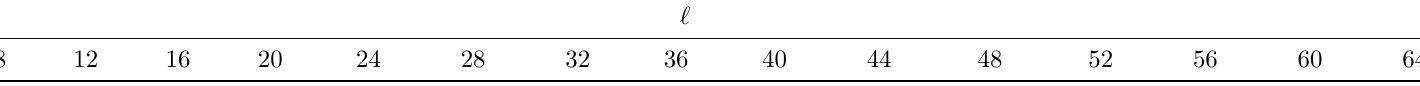
Table 6: Number of the balanced Boolean functions in F n,d with linearity of ℓ , i.e., number of full-dependent n -bit balanced Boolean functions with linearity ℓ and latency complexity d up to the extended bit permutation